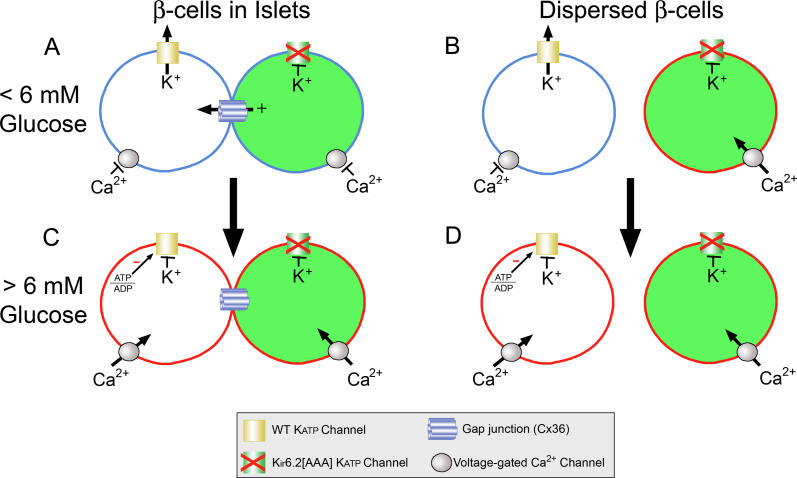
Schematic Model of the Responses of β-cells in the Islet and Dispersed β-cells from Kir6.2[AAA] Transgenic Mice in Both Low (<6 mM) and High (>6 mM) Glucose Concentrations(A) and (C) show the β-cell responses in the islet, and (B) and (D) show the dispersed β-cell responses.(A) A WT β-cell has normal KATP channel activity (white cell), which maintains plasma membrane potential (blue membrane). The GFP-tagged Kir6.2[AAA] cell (green cell) would normally be depolarized; however, the KATP current from the normal cell is coupled through gap junctions to maintain membrane polarity (blue membrane).(B) In the absence of coupling through gap junctions, the cell with normal KATP channel activity (white cell) maintains polarity (blue membrane), but the Kir6.2[AAA] cell depolarizes (red membrane) resulting in Cai influx through voltage-gated channels.(C) The addition of glucose raises the ATP/ADP ratio, which closes the KATP channel in the normal cell. The loss of this K+ current results in membrane depolarization (red membrane) in both cells, and Cai influx through voltage-gated Ca2+ channels.(D) In the dispersed cells, this rise in ATP/ADP ratio results in depolarization and Cai influx occurring in both cells.